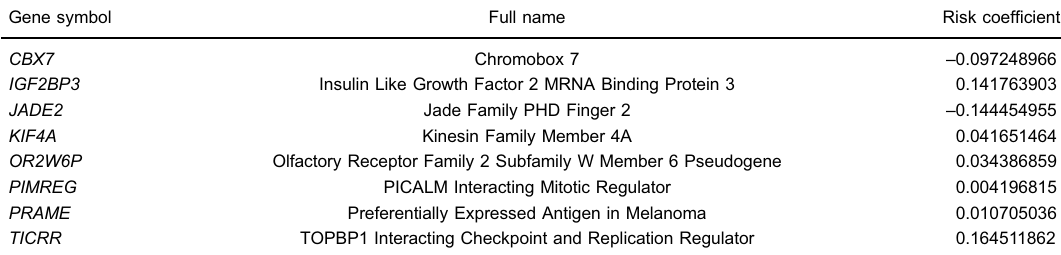
Table 2. Genes in the prognostic gene